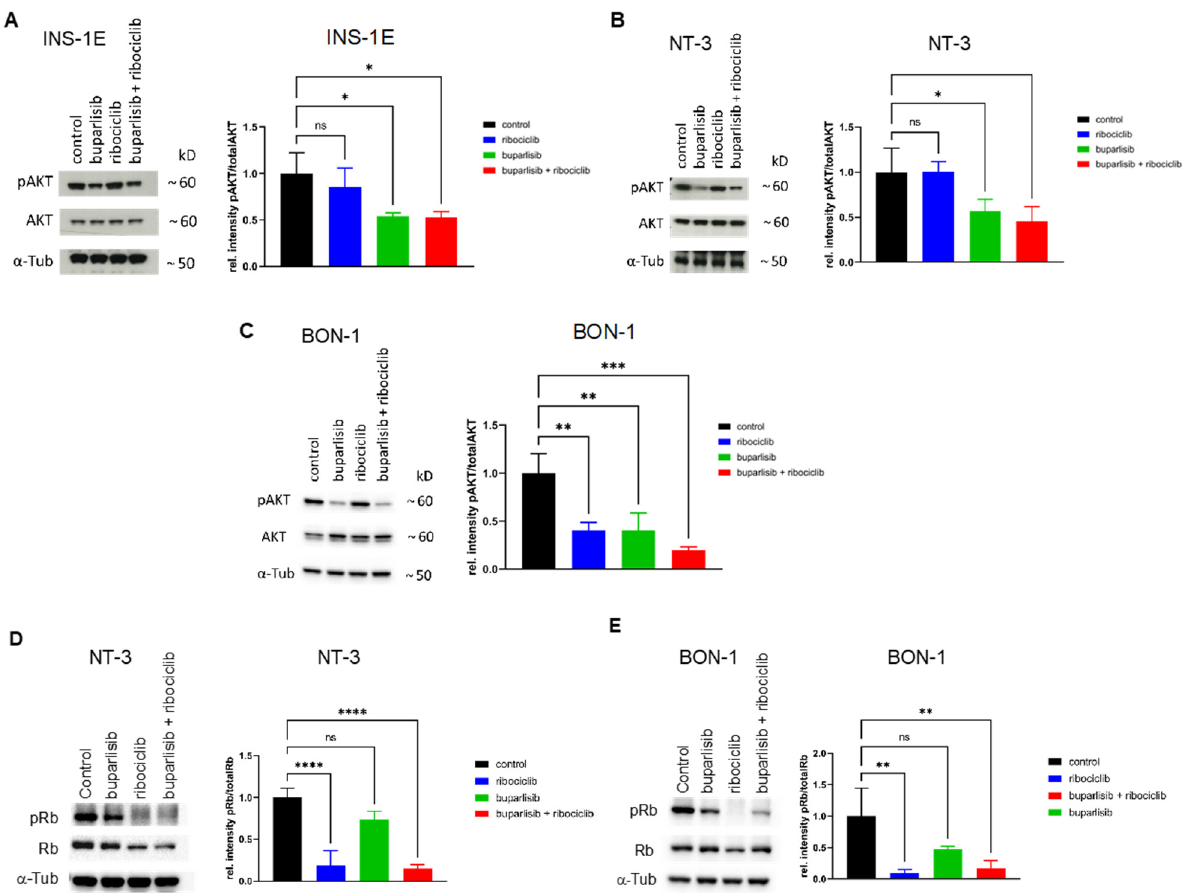
Figure 3. Inhibition of targets of the PI3K pathway and of CDK4/6 confirmed by WB. ( A – C ) Expression of phospho-Akt (P-AKT) and total Akt in INS-1E ( A ), NT-3 ( B ) and BON-1 ( C ) cells treated with buparlisib, ribociclib or their combination. α -Tubulin was used as loading control. Shown is one representative immunoblot (out of three). Additionally, the ratio of the band intensities for P-AKT/AKT is given for each cell line. The mean ± SD from three independent experiments is shown. ( D , E ) Expression of phospho-Rb (P-Rb) and total Rb in NT-3 ( D ) and BON-1 ( E ) cells treated with buparlisib, ribociclib or their combination. α -Tubulin was used as loading control. One representative immunoblot (out of three) is shown. Additionally, the ratio of the band intensities for P-Rb/Rb is given for each cell line. The mean ± SD from three independent experiments is shown; ns, not significant; *, p < 0.05; **, p < 0.01; ***, p < 0.001; ****, p < 0.0001.